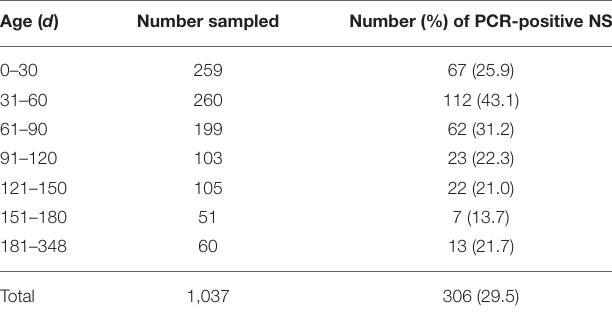
TABLE 3 | Number of nasal swabs (NS) sampled from 30 dairy herds and number (%) of M. bovis PCR-positive swabs per age group ( d = age in